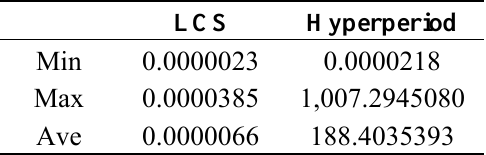
Table 1. Comparative results of computation